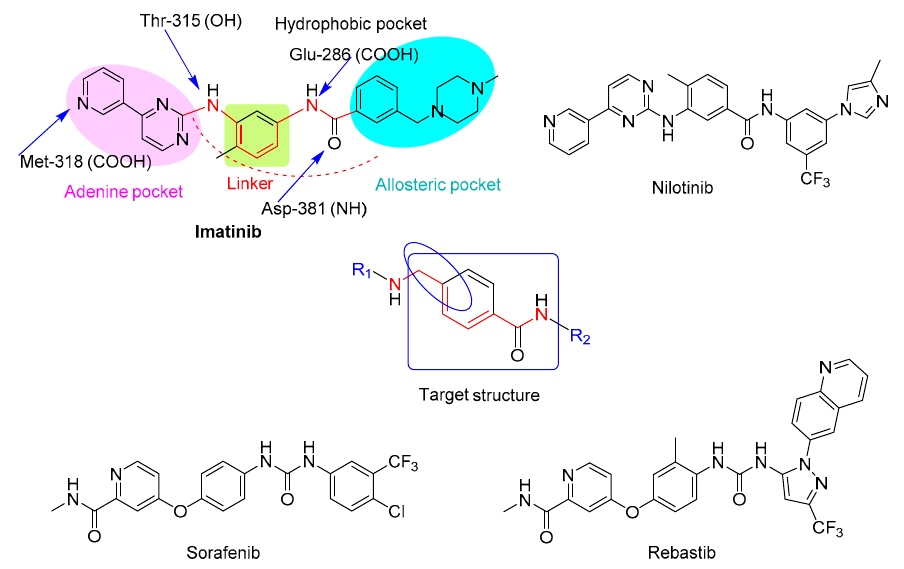
Figure 1. Inhibitors of the tyrosine kinase type II and target structure. Interactions between imatinib and Brc-Abl tyrosine kinase.